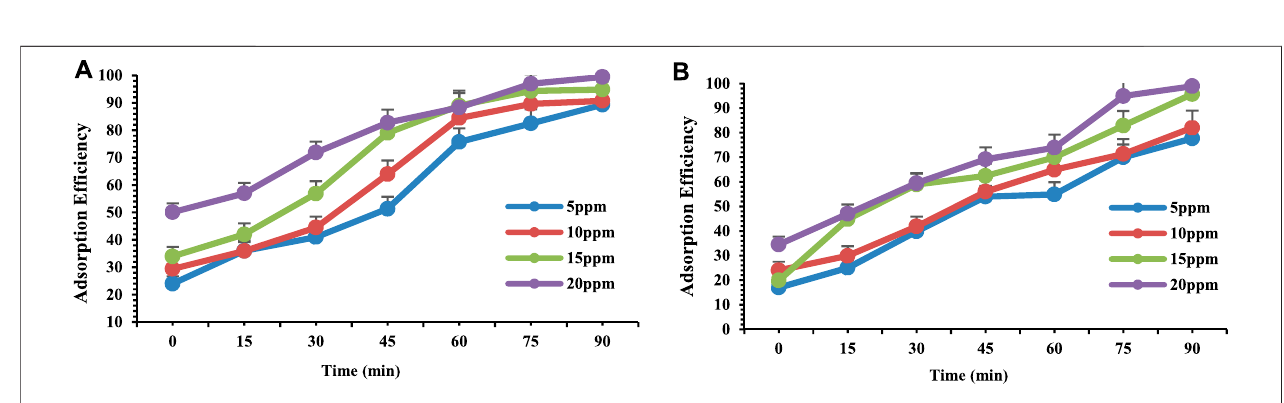
FIGURE 7 | Adsorption ef fi ciency of (A) Chromium and (B) Lead at pH4 on orange peel/selenium nanocomposite as a function of metal concentration.